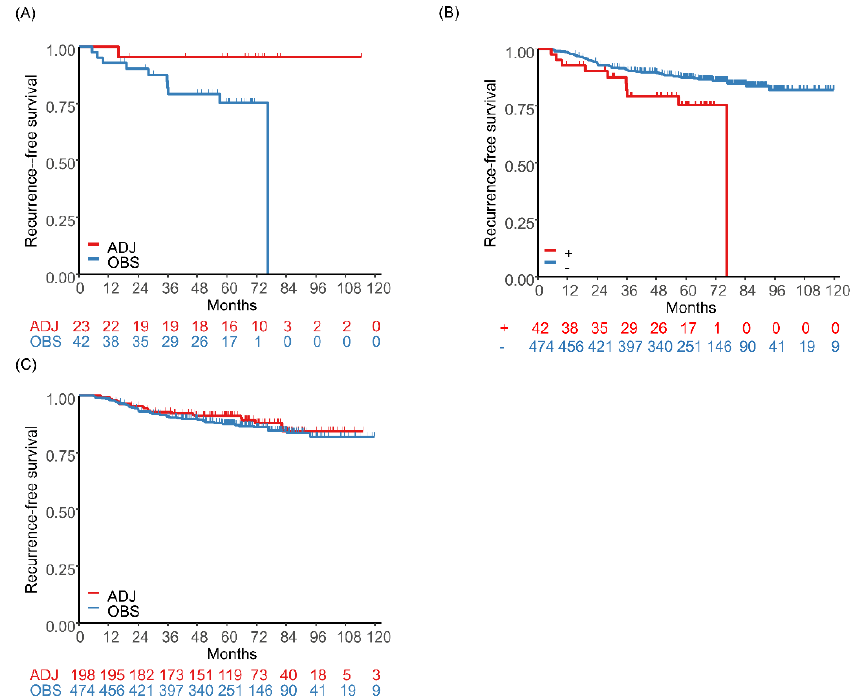
Figure 2. Analyses of patients aged ≥ 65 years with stage I adenocarcinoma who received adjuvant tegafur/uracil (UFT) therapy or underwent observation. ( A ) comparison of RFS between the adjuvant UFT therapy group and the observational group in patients who were actinin-4 (ACTN4) gene amplification positive, ( B ) comparison of RFS between ACTN4 gene amplification negative and positive patients in the observational group, and ( C ) comparison of RFS between the adjuvant UFT therapy group and the observational group (Noro, R. et al., 2022 [34]).